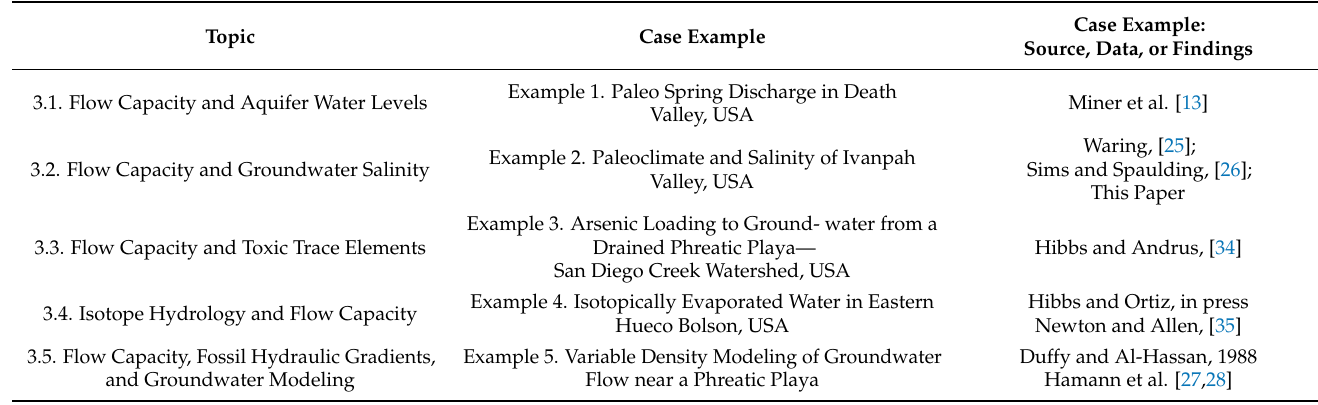
Table 1. Topics and Case Examples Related to Aquifer Flow Capacity and Paleoclimate and Anthro- pogenic